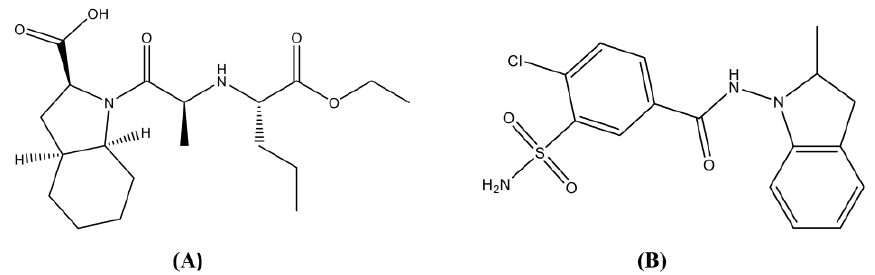
Figure 1. Chemical structures for ( A ) Perindopril and ( B ) Indapamide.